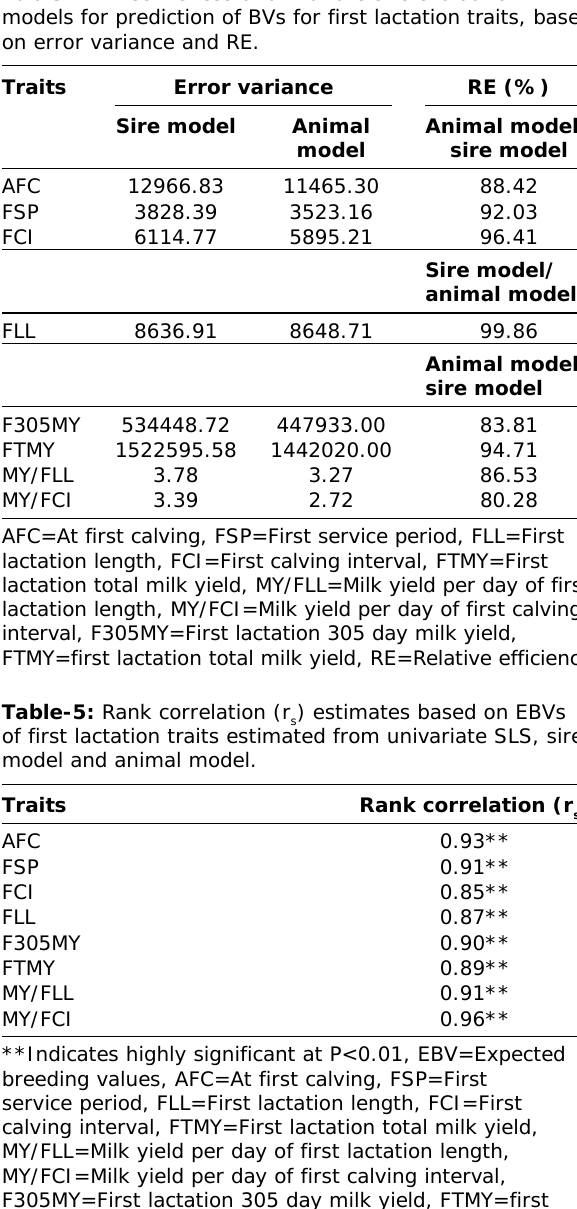
Table-4: Effectiveness of univariate sire evaluation models for prediction of BVs for first lactation traits, based on error variance and